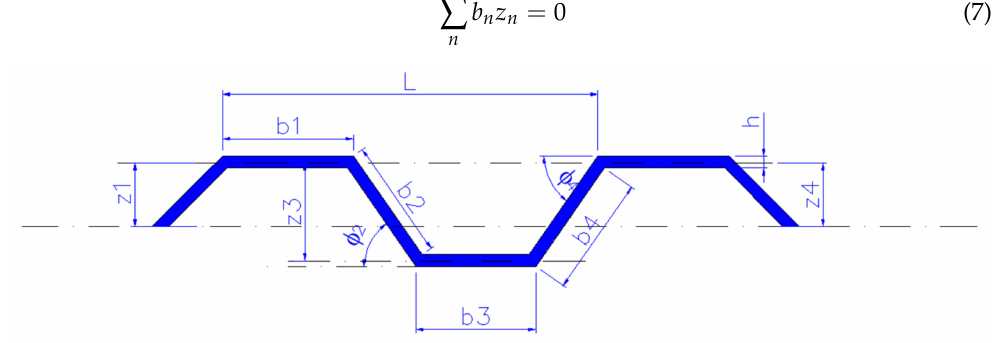
Figure 2. Corrugated plate